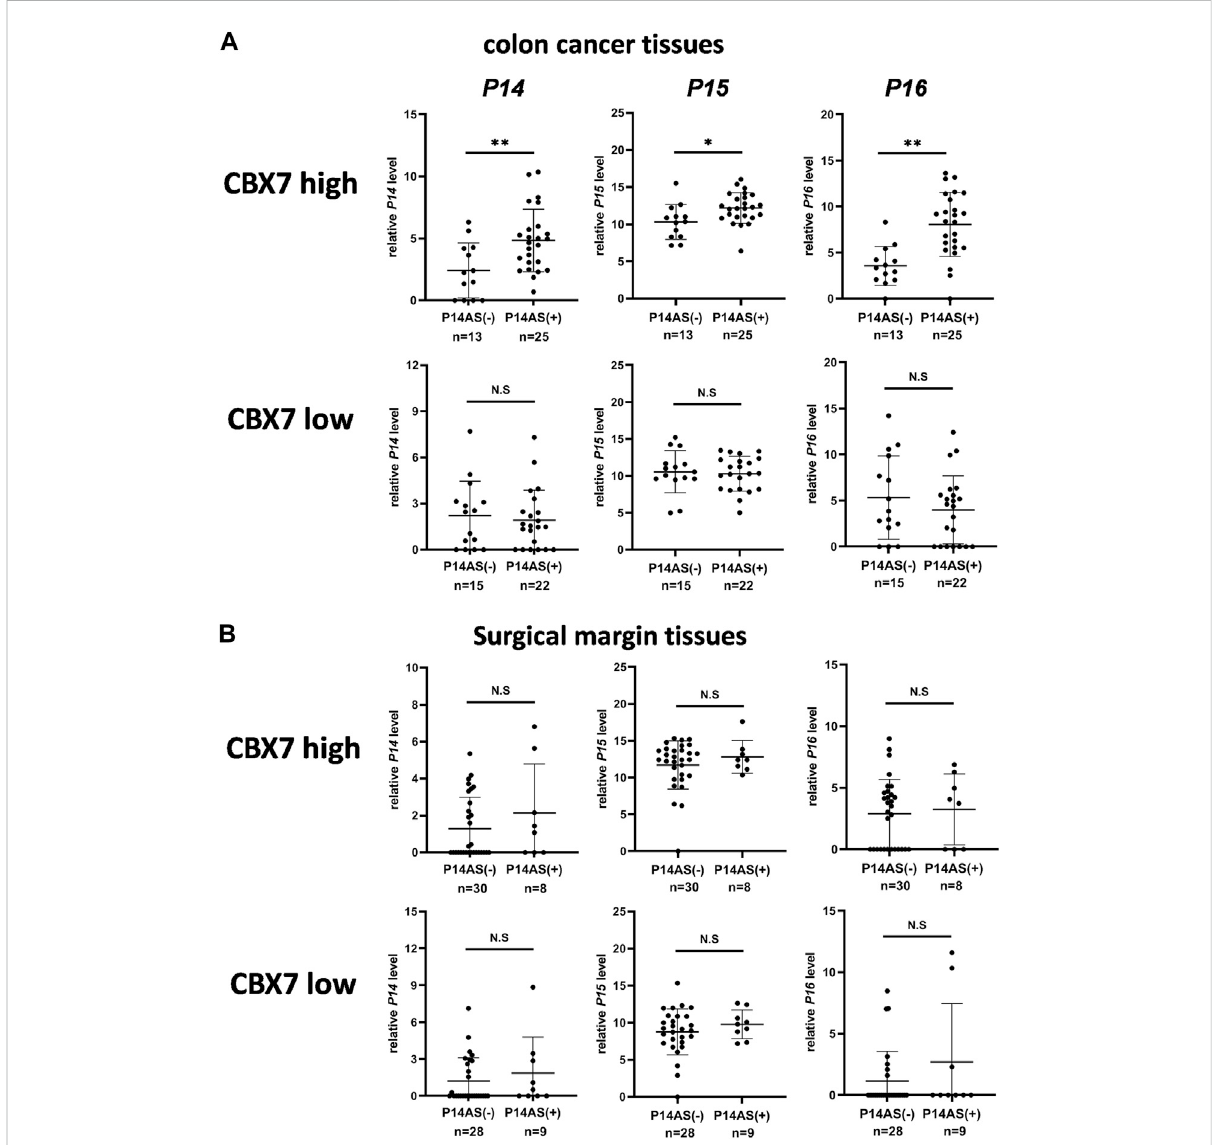
FIGURE 5 Coexpression of P14AS with P14 ARF , P15 INK4B and P16 INK4a genes in human colon cancer tissues with high CBX7 expression. (A) Colon cancer tissues; (B) Surgical margin tissues. N.S: not signi fi cant. *: p < 0.05. **: p <